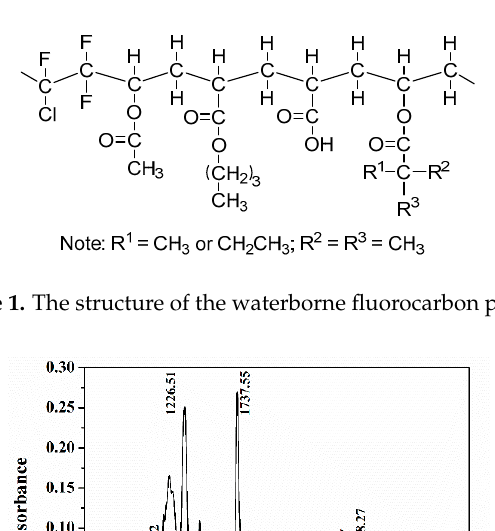
Figure 2. Fourier transform infrared (FT-IR) spectrum of the waterborne fluoropolymer of P1 .